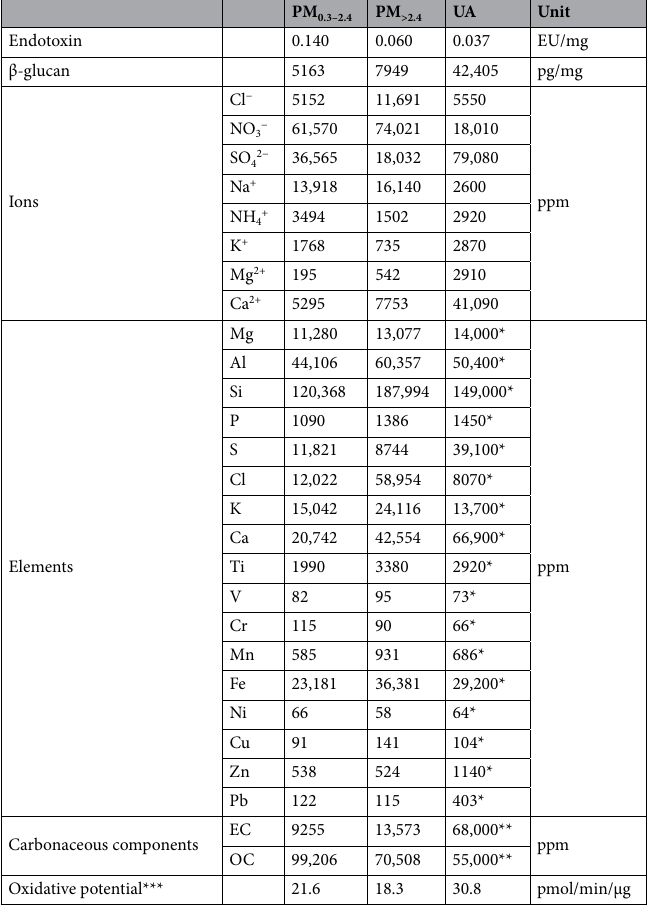
Table 1. Concentrations of endotoxin, β-glucan, ions, elements, and carbonaceous components in particle matters and oxidative potential. *Refer to Mori et al. 20 . **Refer to Okuda 53 . ***Measured by dithiothreitol